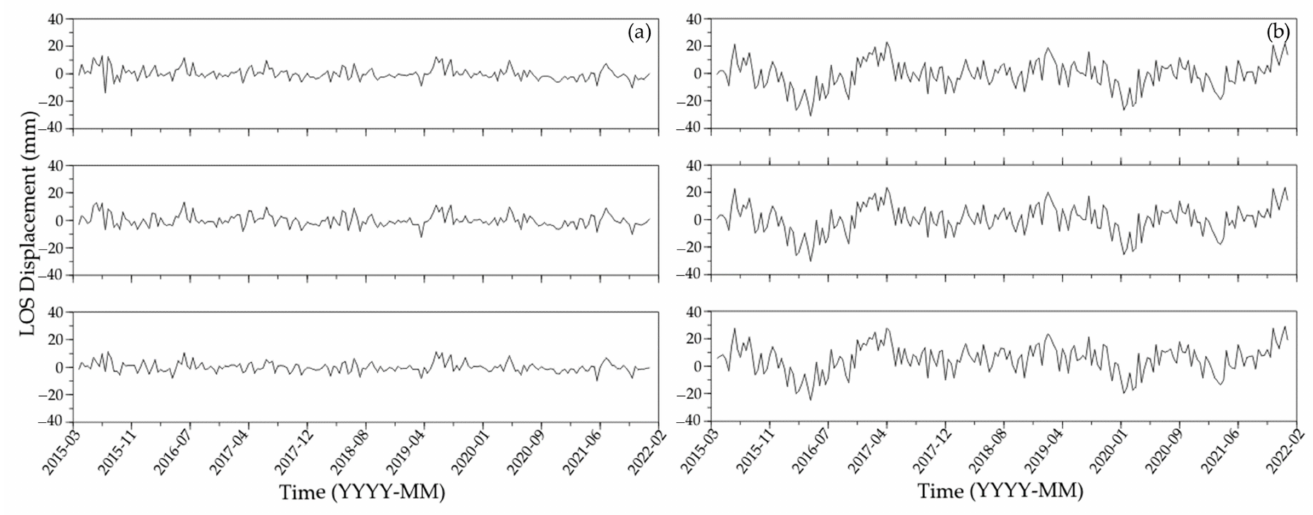
Figure 1. Example of six different PS with similar LOS velocities of ~0 mm/y but time-series in ( a ) strongly differ from those in ( b